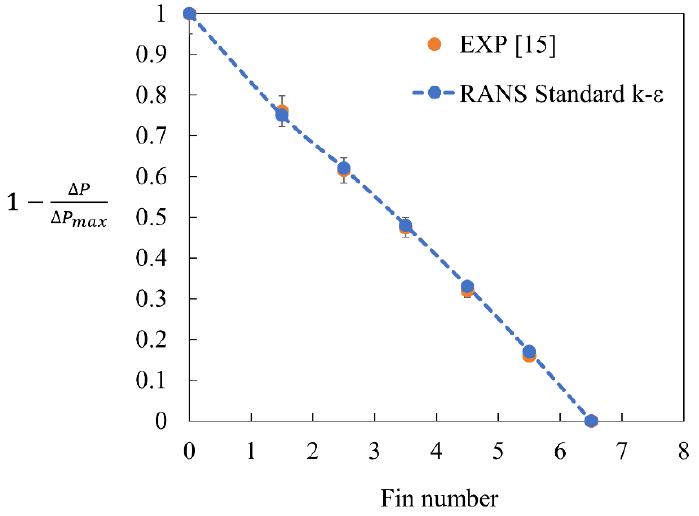
Figure 7. Pressure distribution in the labyrinth seal for a pressure ratio of 1.38. Fin number refers to the number assigned to six fins in the baseline labyrinth seal.